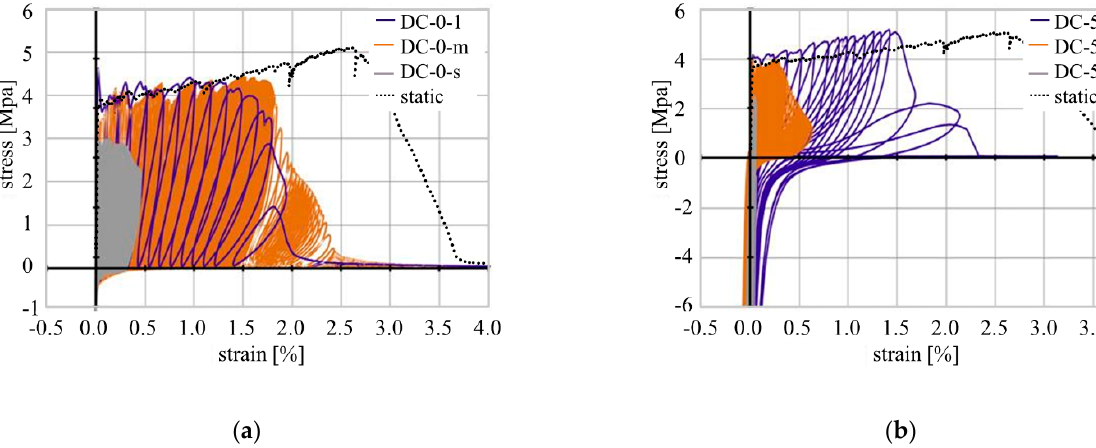
Figure 6. Representative stress-strain curves measured in deformation-controlled cyclic tests compared to a typical quasi- static test: ( a ) pure tension; ( b ) alternating tension-compression with lower reversal point at 50% of the compressive strength.